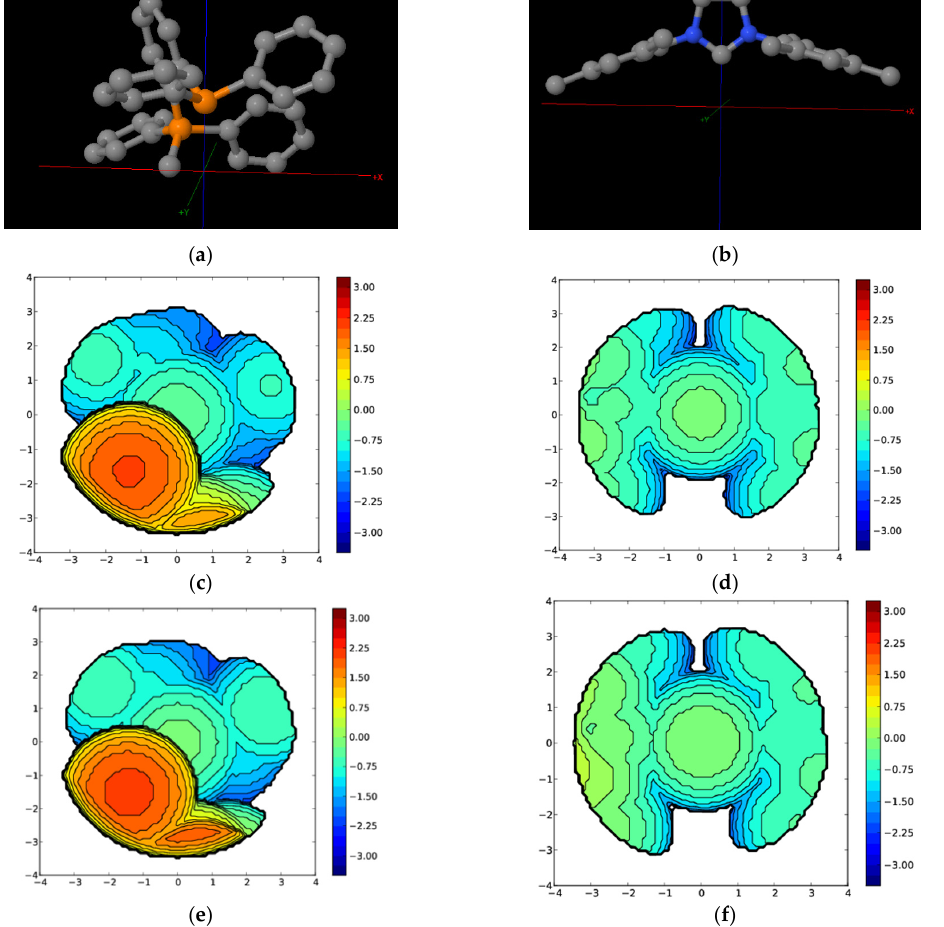
Figure 6. Orientation axes for the ( a ) phosphine–phosphonium ylide and ( b ) NHC ligand (colours: orange: P; gray: C; and blue: N); steric maps for the species “ PPh 3 ” corresponding to the complexes ( c ) A and ( d ) B ; and steric maps for species 14e1 of complexes ( e ) A and ( f ) B . The Ru atom is at the origin and the P atom is on the z axis. The isocontour curves of the steric maps are given in Å. The radius of the sphere around the metal center was set to 3.5 Å; the Bondi radii were scaled by 1.17 for all the atoms, and a mesh of 0.1 Å was used to scan the sphere for buried voxels. Table 2. Main distances for complexes A and B (in Å).